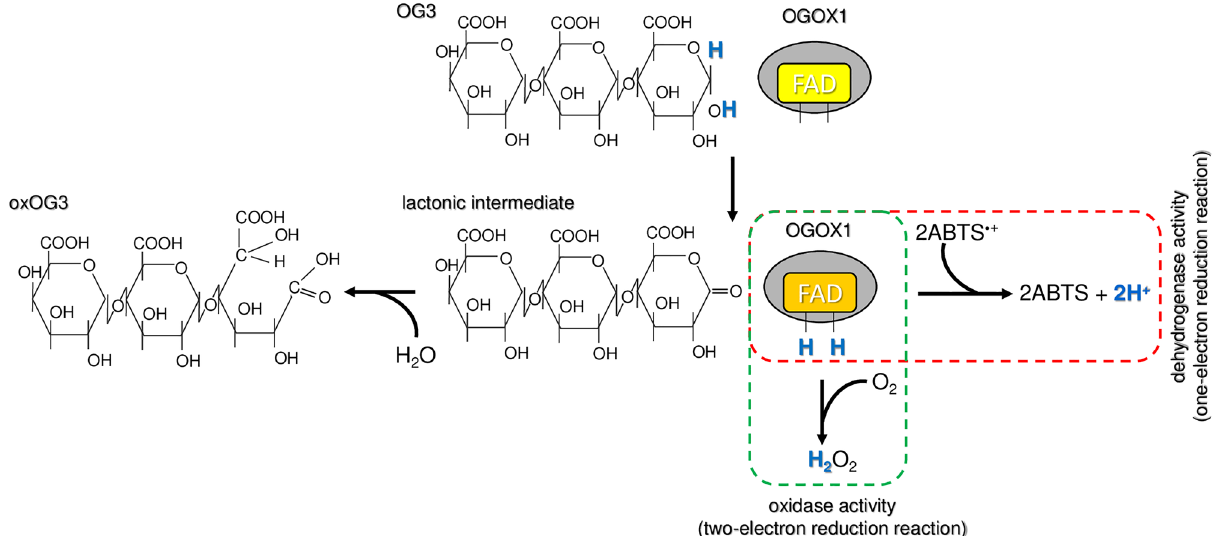
Figure 6. Model of the ABTS ·+ -scavenging reaction catalyzed by an OSOX/short oligosaccharide combination. In the conventional reaction (dotted green box), OGOX1 oxidizes OG3 to a lactonic intermediate by transferring two electrons to one molecule of O 2 (oxidase activity, two-electron reduction reaction). In the ABTS ·+ -scavenging reaction (dotted red box), OGOX1 oxidizes OG3 to a lactonic intermediate by transferring two electrons to two molecules of ABTS ·+ (dehydrogenase activity, one-electron reduction reaction). In both reactions, the lactonic intermediate is then spontaneously hydrolyzed to oxOG3 (GalUc1–4αGalUc1– 4Galactaric acid). OGOX1 and OG3 are used here as representative OSOX/short oligosaccharide combination